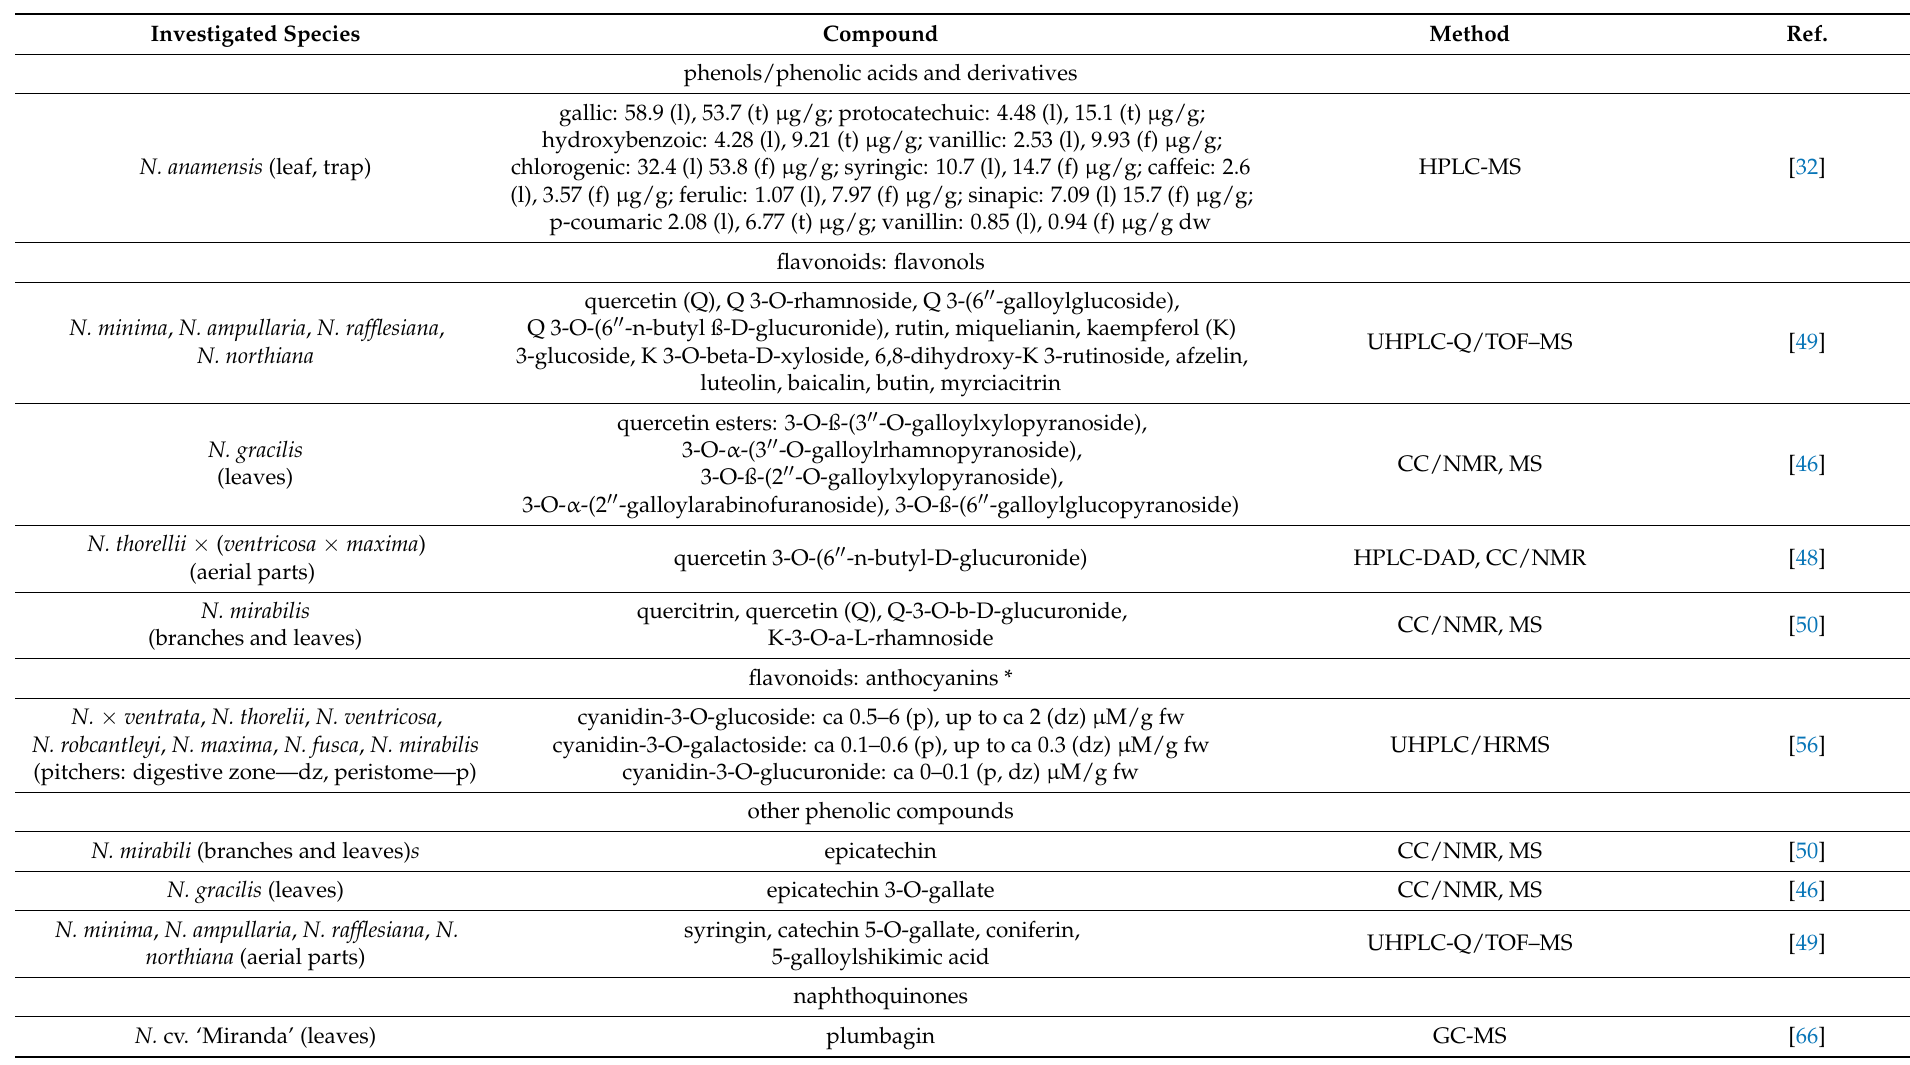
Table 1. Secondary metabolites identified in Nepenthes